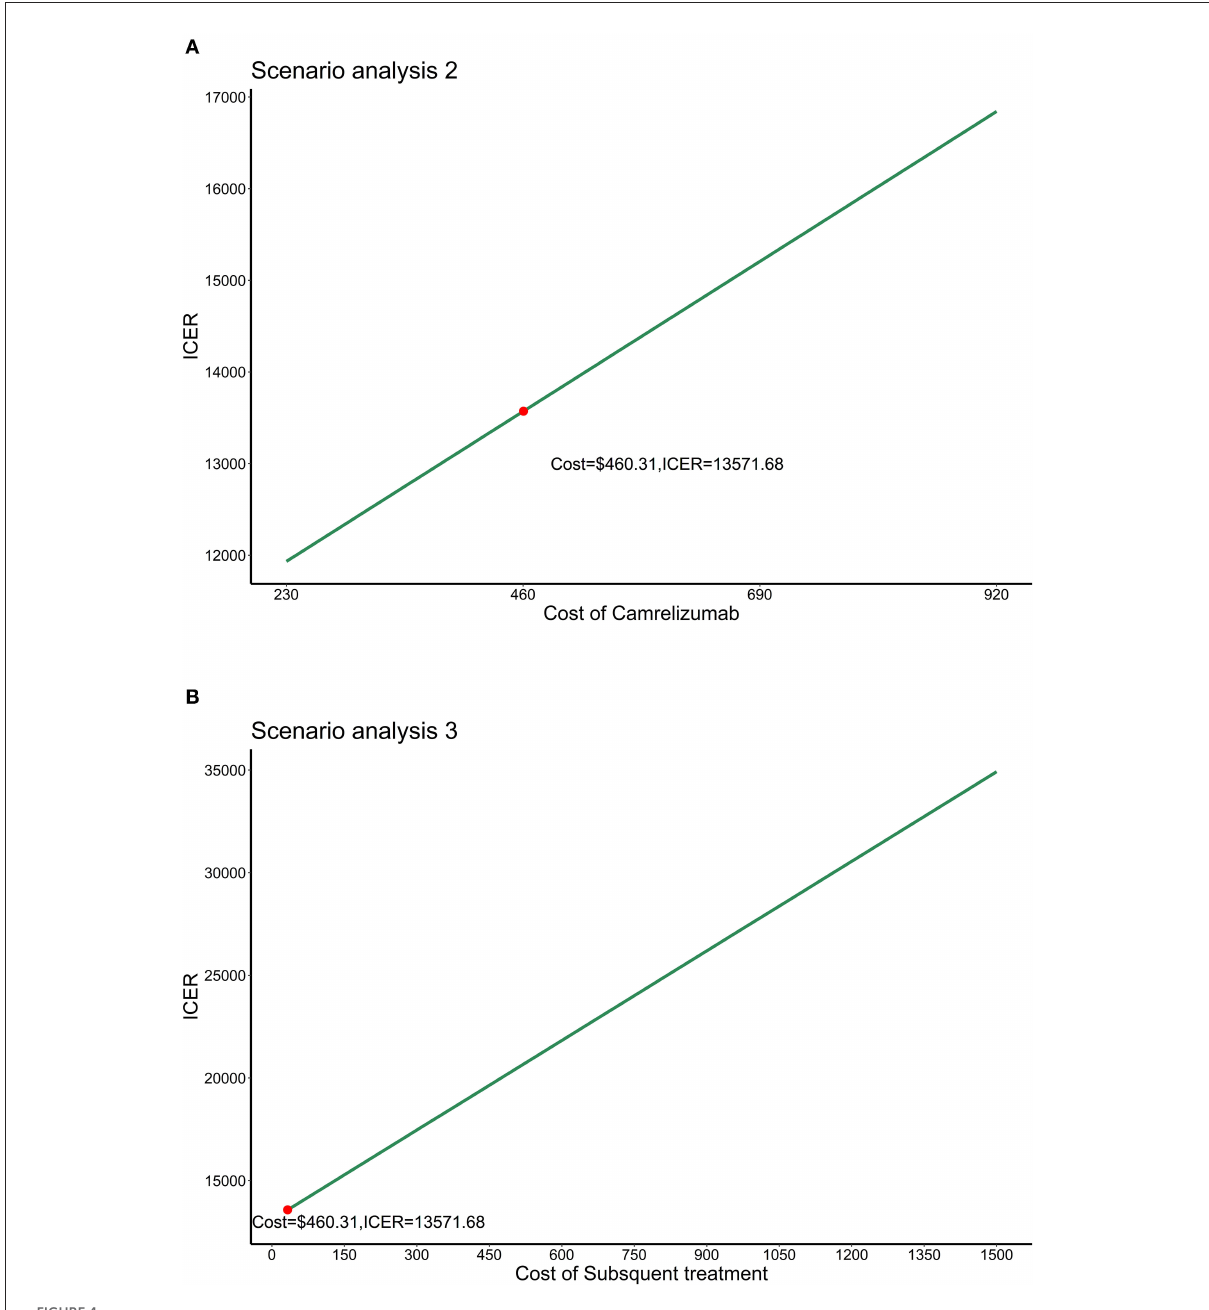
FIGURE4 Results of scenario analysis 2 and 3. (A) Results of scenario analysis 2. (B) Results of scenario analysis 3. ICER, Incremental cost-effectiveness ratio.